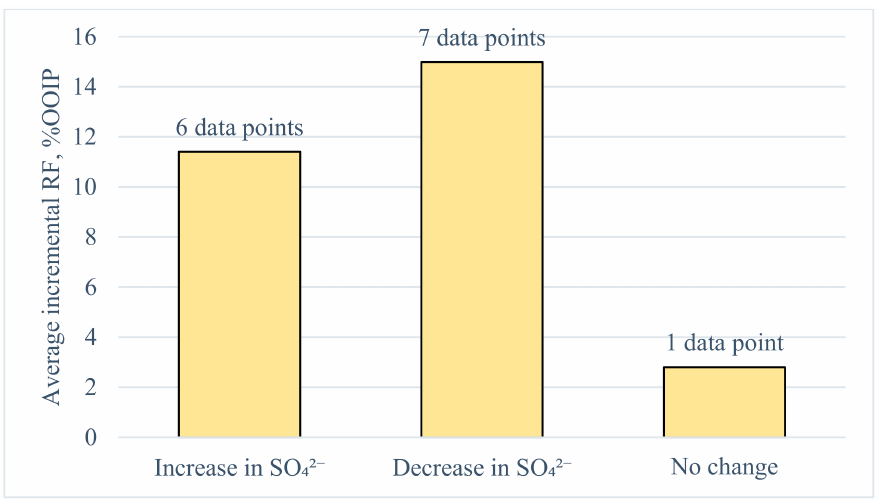
Figure 8. Average incremental RF vs. SO 42 − concentration